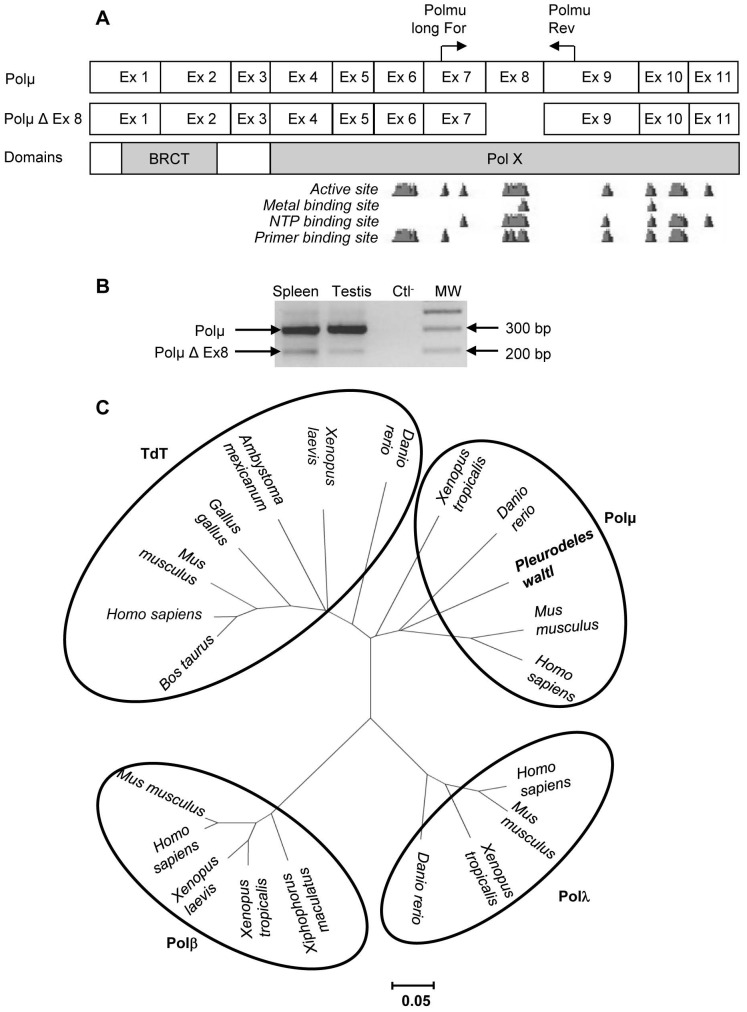

Pleurodeles waltl DNA polymerase µ.Schematic representation of P. waltl Polµ mRNAs (A). The short variant (Polµ Δ Ex 8) presents a 103 bp deletion corresponding to exon 8. This deletion removes one part of the active site of the protein. The BRCT (breast cancer suppressor protein carboxy-terminal) and the Pol X domain, which contains the active site, are required for Polµ function. Polµ variants were amplified using primers indicated by horizontal arrows (B). Quantification of the obtained PCR products using a Gel Doc 2000 and the Quantity One v.4.3.1 software (Bio-Rad, Hercules, CA, USA) indicates that the short isoform represents 16% and 6% of the Polµ transcripts in the spleen and testis of P. waltl, respectively. Ctl− = negative control. MW = 100 bp DNA ladder. A cladogram was then constructed by neighbor joining (C) supported with 1000 bootstrap replications using the MEGA4 software (http://www.megasoftware.net/) and the following sequences: Terminal deoxynucleotidyl transferase (TdT); Bos taurus (DAA14763), Homo sapiens (BAB72001), Mus musculus (NP_001036693), Gallus gallus (NP_990720), Ambystoma mexicanum (AA092254), Xenopus laevis (NP_001079251), Danio rerio (AAS89780). Polymerase beta; Mus musculus (NP_035260), Homo sapiens (NP_002681), Xenopus laevis (NP_001081643), Xenopus tropicalis (AAH74537), Xiphophorus maculatus (AAU11319). Polymerase lambda; Danio rerio (NP_998408), Xenopus tropicalis (NP_001093716), Mus musculus (NP_064416), Homo sapiens (NP_001167555). Polymerase mu; Homo sapiens (NP_037416), Mus musculus (NP_059097), Danio rerio (NP_956542), Xenopus tropicalis (NP_001164987), Pleurodeles waltl (HE583591). The scale bar corresponds to the evolutionary distance.